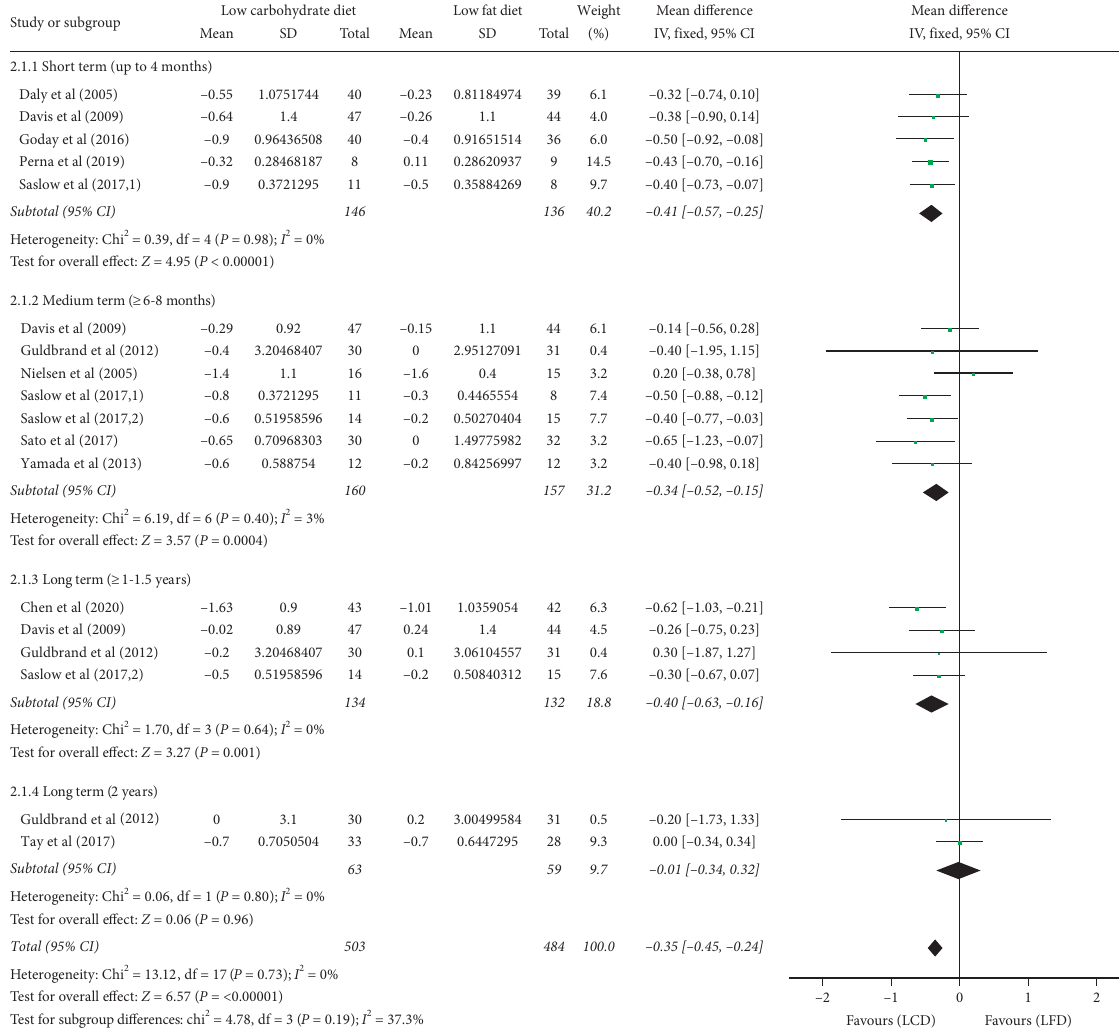
Figure 3: Forest plot for the effect of restriction diets on HbA1c. LCD: low-carbohydrate diet; LFD: low-fat diet; HbA1c: glycated haemoglobin; CI: confidence interval; SD: standard